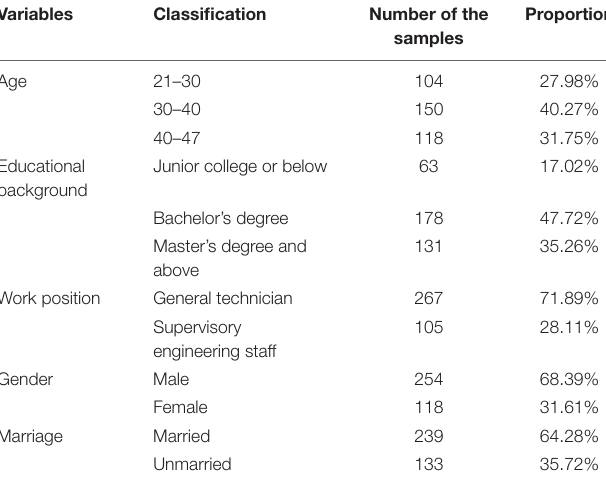
TABLE 1 | Basic information of employees of the tested